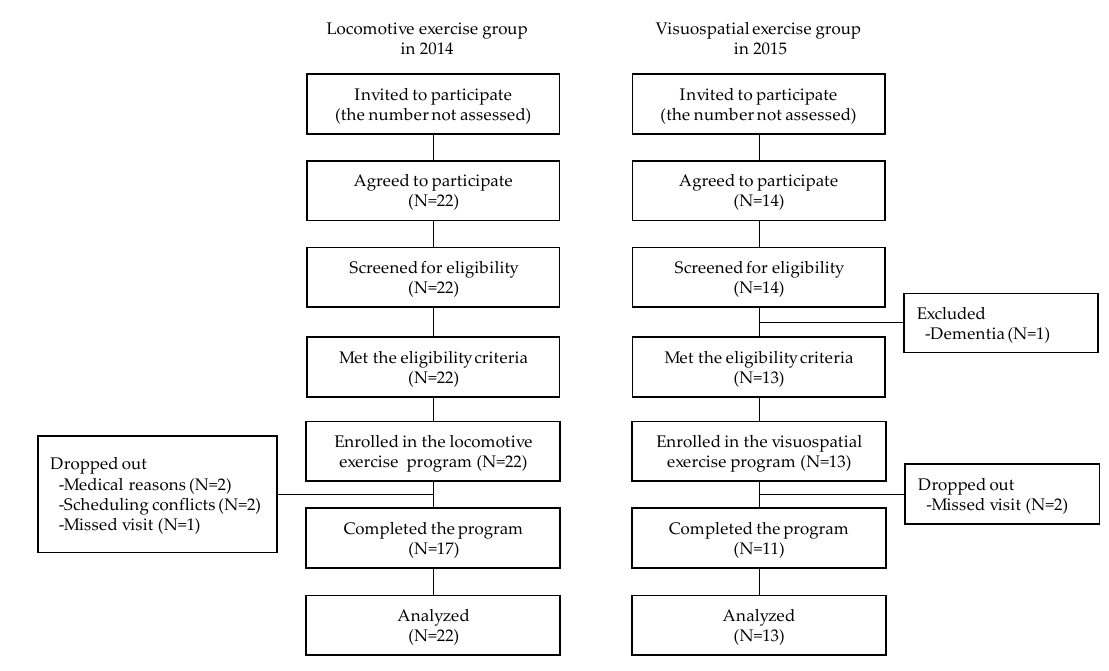
Figure 3. Flowchart of the study participants.